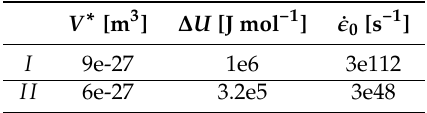
Table 5. Eyring parameters for α -III.